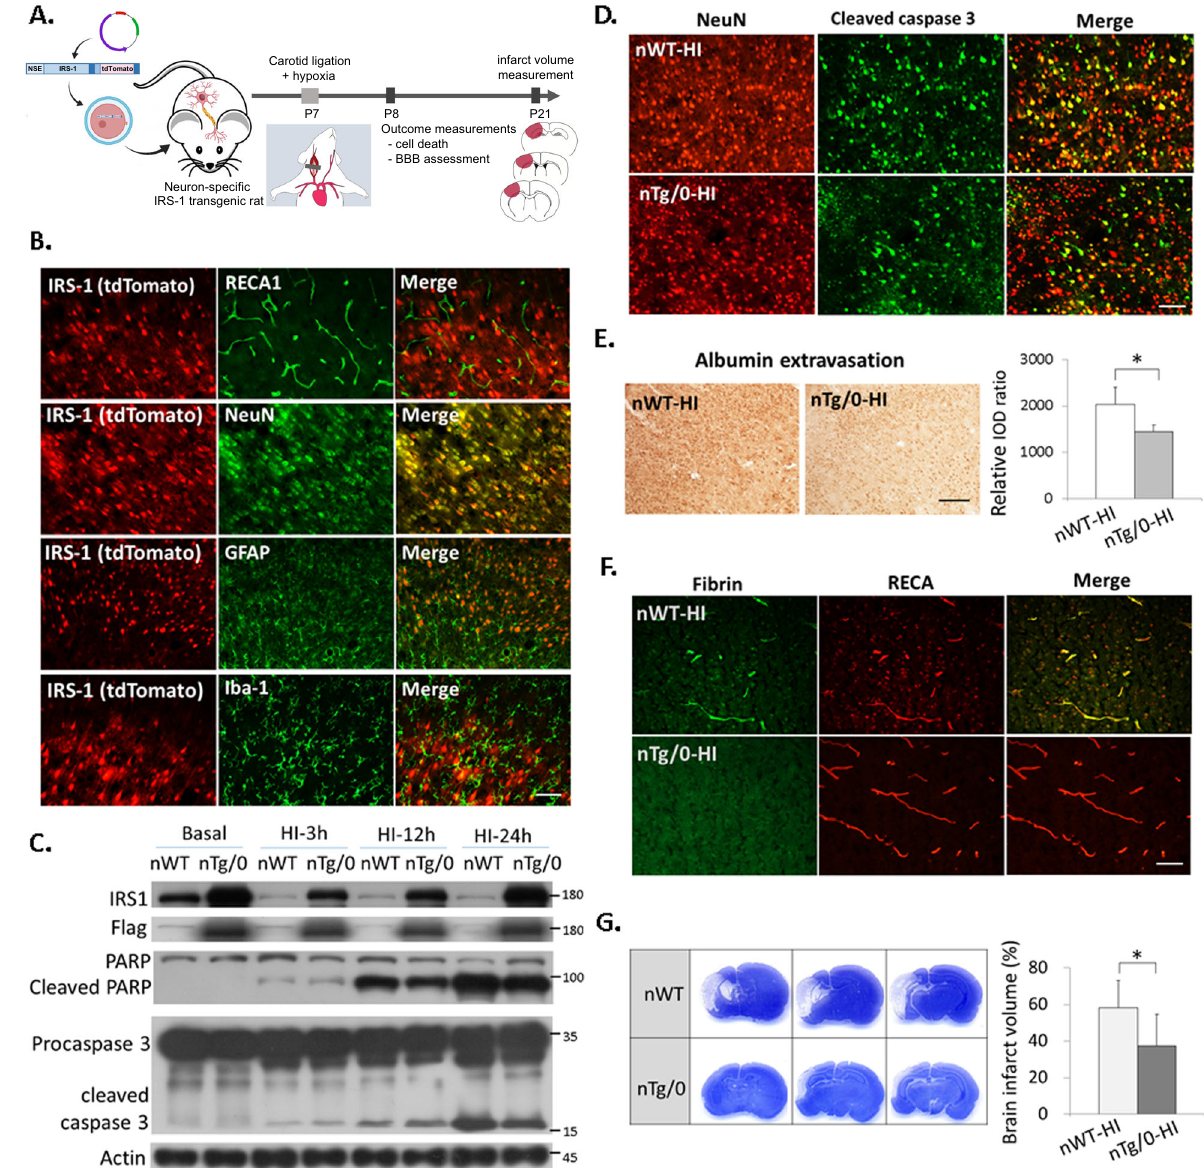
Fig. 2 Neuron-speci fi c IRS-1 transgenic rats had reduced neurovascular injury and brain damage after HI. A Diagram of the experimental procedure in the neuron-speci fi c IRS-1 transgenic rats (nTg/0) and wild-type littermates (nWT): HI on P7, and outcome assessments on P8 and P21. The transgene contains neuron-speci fi c promoter (NSE), full-length IRS-1 tagged with 3x Flag and IRES-directed tdTomato. B The IRS-1/ tdTomato were expressed speci fi cally on NeuN ( + ) neurons, and not on RECA( + ) endothelium cells, GFAP( + ) astrocytes or Iba-1( + ) microglia in the cerebral cortex of P7 rat pups. Scale bar: 50 μ m. C The nTg/0 rats showed upregulated IRS-1 in the brain, and reduced cleaved-PARP, and – capsease 3 after HI compared to the nWT rats. N = 4 D The cleaved caspase 3 ( + ) and NeuN ( + ) apoptotic neurons were reduced in the nTg/0 rats than that in the nWT rats at 24 h after HI. N = 4, Scale bar: 50 μ m. E Representative images illustrate albumin extravasation in the cerebral cortex at 24 h after HI between the nTg/0 than nWT rats, and the relative integrated optic density (IOD) of albumin signal was quanti fi ed and compared between groups. Scale bar: 125um. Independent t -test was used for statistical analysis ( N = 5, P = 0.017, t = 3.402). The data are presented as mean ± SD. * P < 0.05. F The nTg/0 rats had less perivascular fi brin deposits than that of the nWT rats at 24 h after HI. N = 4, Scale bar: 50 μ m. G The brain infarct volume on P21 (14 days after HI) was quanti fi ed and compared between the nTg/0 and nWT rats. Independent t -test was used for statistical analysis ( N = 10, P = 0.01, t = 2.888). The data are presented as mean ± SD. * P < 0.05.